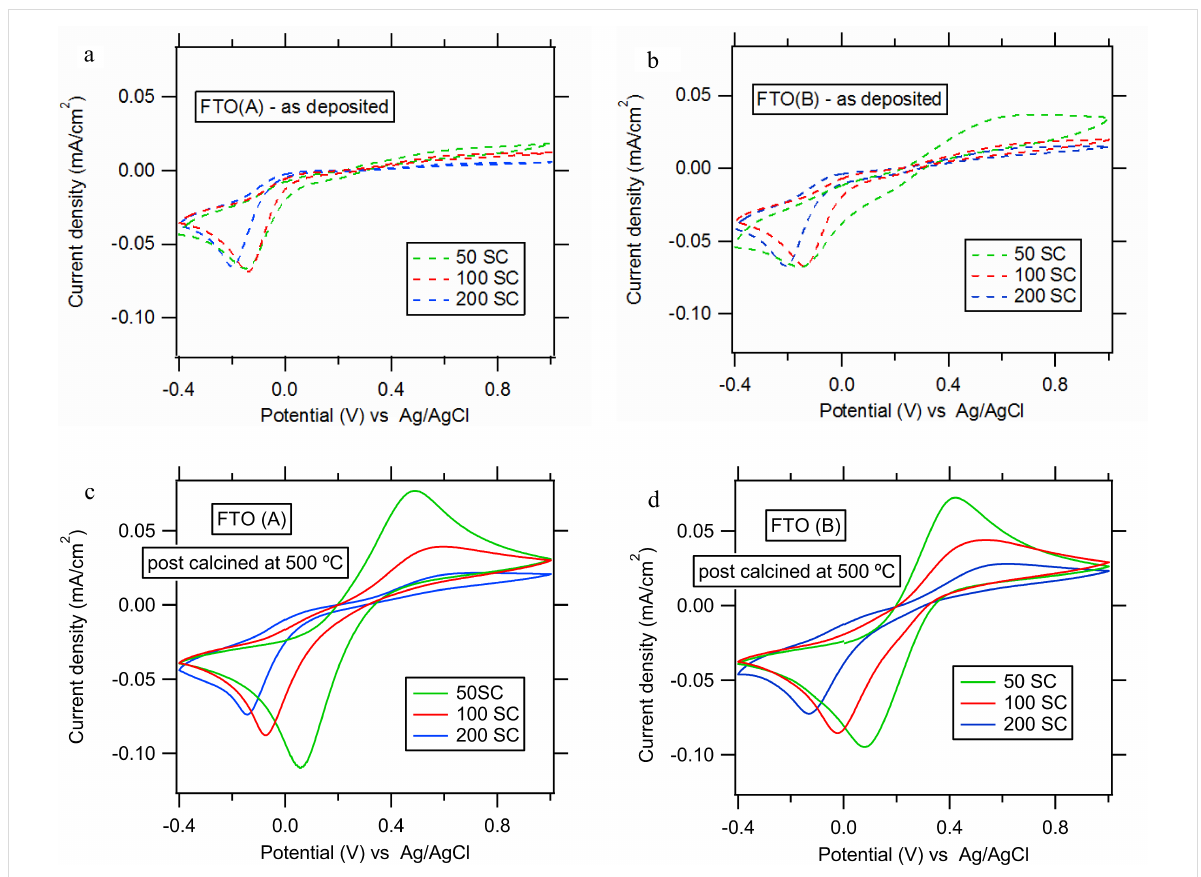
Figure 4: Cyclic voltammograms for TiO 2 films; precursor: 0.05M TAA, deposition temperature: 450 °C, scan rate: 50 mV/s, electrolyte solution: 0.5 mM Fe(CN) 63 − /4 − in aqueous 0.5 M KCl, pH 2.5. (a,c) films deposited on FTO(A) 50, 100 and 200 SCs, (b,d) films deposited on FTO(B) 50, 100 and 200